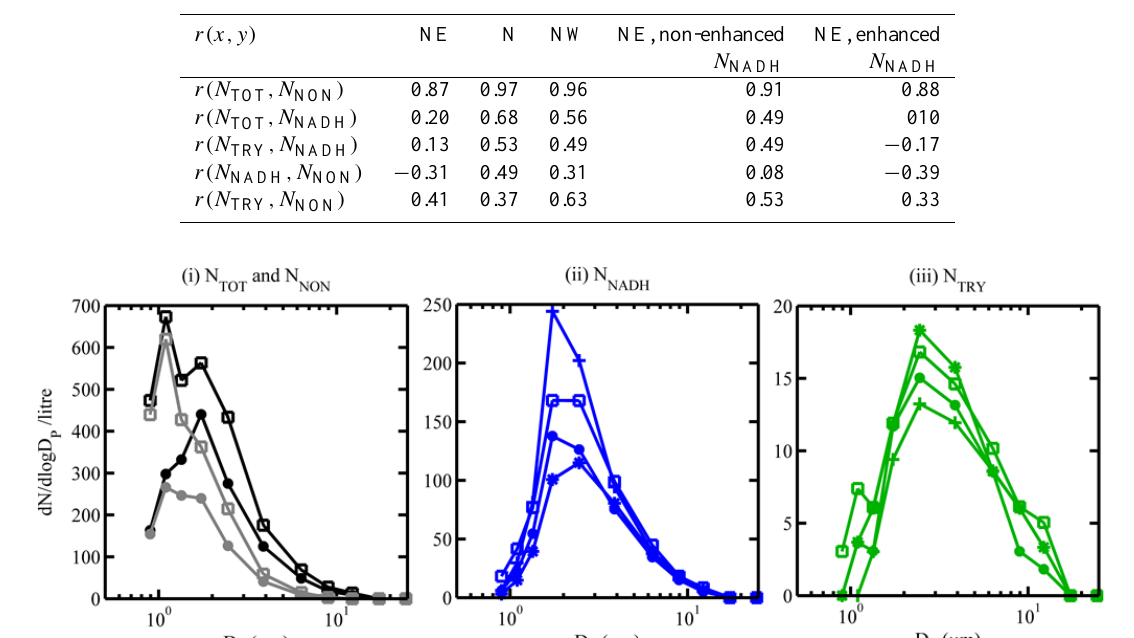
Fig. 2. Median number size distributions for different WIBS-3 concentrations broken down by periods of different influence. Solid circle: median for entire campaign; square: during N air mass; (*): between NNADH enhancements; (+): during NNADH